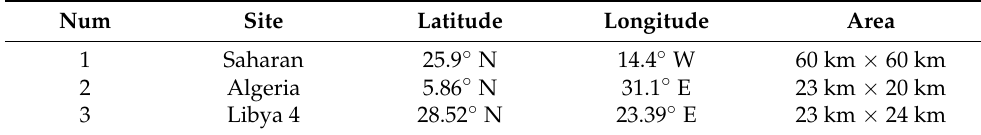
Table 3. The uniform sites for relative radiometric accuracy